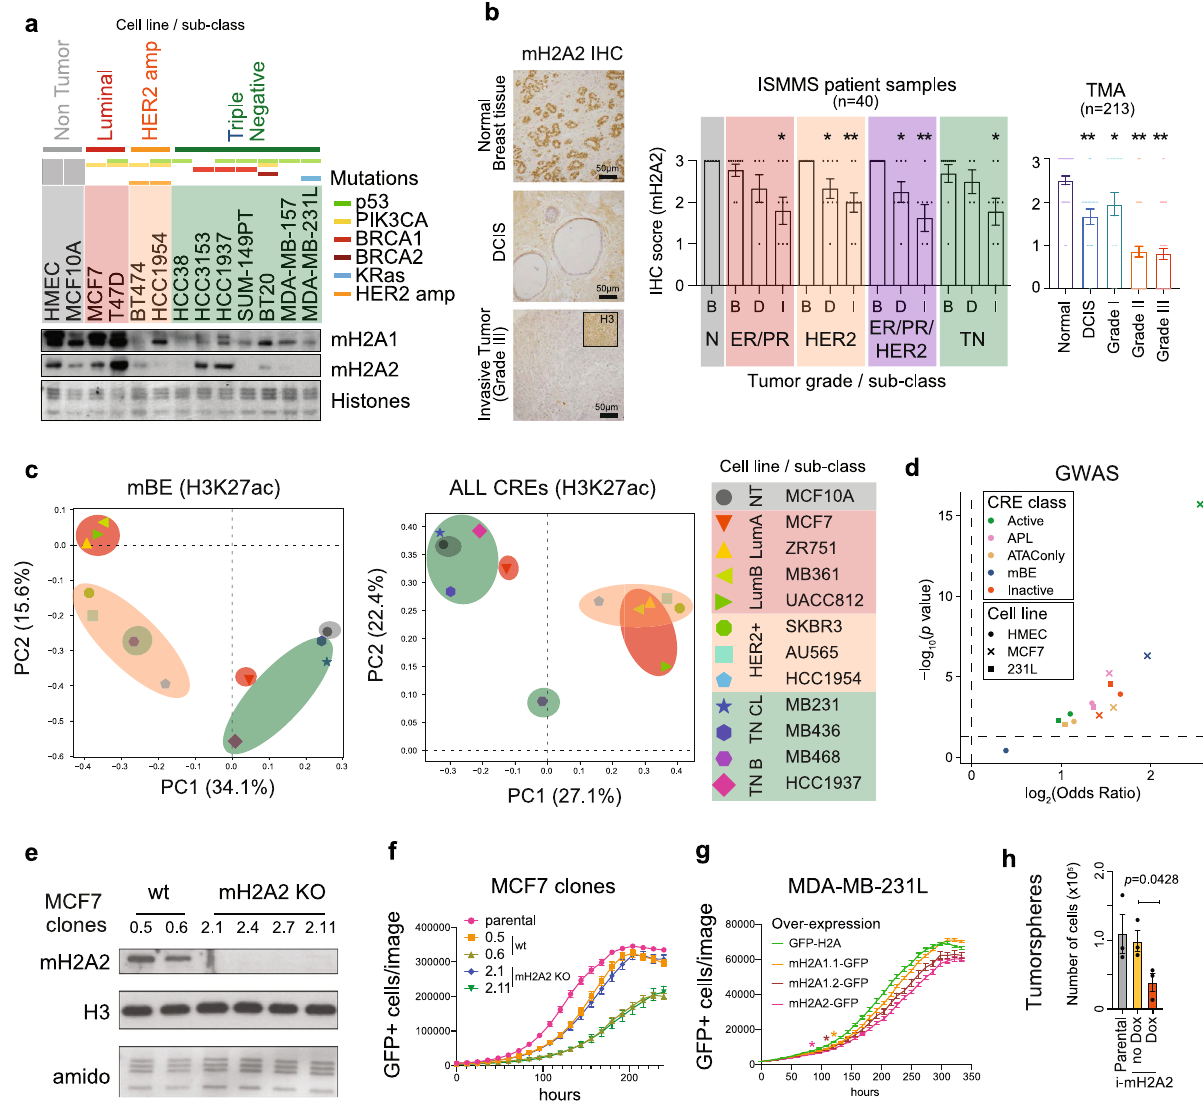
Fig. 4 Reactivation of macro-Bound Enhancers associates with oncogenic programs. a Immunoblot of chromatin extracts were probed for mH2A1 and mH2A2 across a panel of breast cancer cell lines including the three different major sub-types (Luminal, HER2 positive and triple negative), and non- tumorigenic cells (human mammary epithelial cells, HMEC; and immortalized mammary cells MCF10A). Mutational status de fi ned above. Amido Black of core histones used as loading control. b Immunohistochemistry (IHC) from normal breast tissue, ductal carcinoma in situ (DCIS) and grade III invasive tumors for mH2A2. Histone H3 IHC was used as a control (top right). Quanti fi cation of mH2A2 scoring for TMA and ISMMS patient samples according to the tumor grade or sub-class (below). B – Benign tissue, D – DCIS, I – Invasive. Column bar represents mean and SE. Unpaired (two tailed) student ’ s t -test * p < 0.05, **p < 0.005. c Principal component analysis of H3K27ac ChIP-seq signal in HMEC macro-Bound enhancers (left) and all CREs (right) in 12 breast cancer cell lines from Franco et al. 41 . d Volcano plot showing enrichment of breast cancer risk variants from GWAS studies (GWAS p -value < 5 × 10 − 8 ), in each CRE class in HMEC, MCF7 and 231 L cells, enrichment p -value and odds ratio calculated using GARFIELD. e Immunoblots for mH2A2 from chromatin extracts in MCF7 clones. H3 and histones (amido black) used as loading controls. f Proliferation of MCF7 clones (wild type and mH2A2 KO ) transduced with H2A-GFP and analyzed by number of GFP cells using Incucyte. Data represented are mean with SE ( n = 3). g Proliferation of MDA-MB-231L cells with over-expression of mH2A-GFP constructs (and H2A-GFP as control) determined by the number of GFP positive cells on Incucyte. Data are mean with SD ( n = 9). Proliferation of cells over-expressing of mH2A1.1-GFP is signi fi cantly lower than control starting at 120 hours, mH2A1.2-GFP at 108 hours